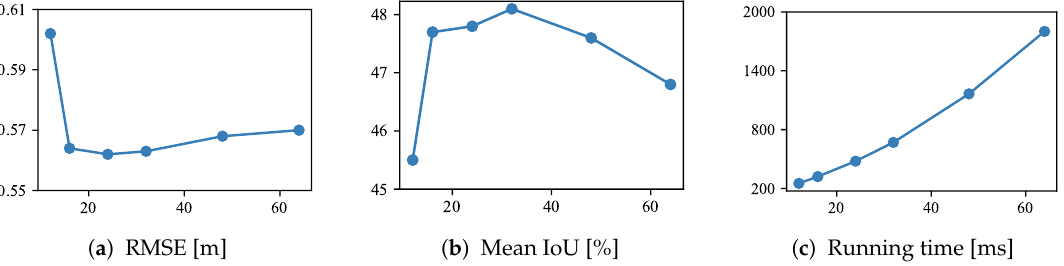
Figure 5. Performance with a different number of depth